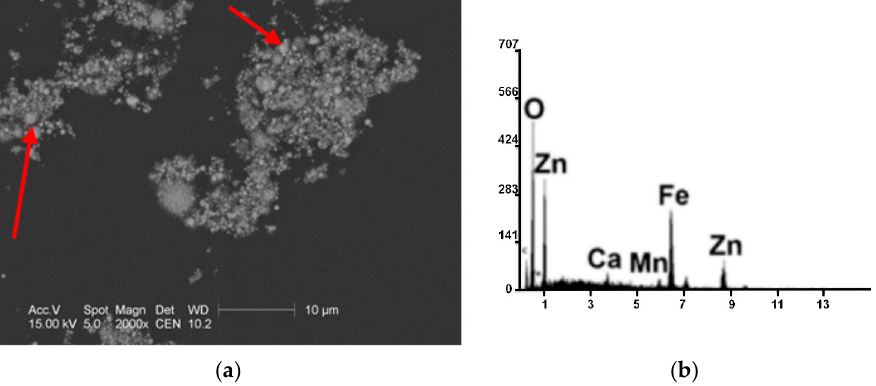
Figure 5. Particles composed of franklinite–jacobsite in steel dust, sample No. 17: ( a ) SEM image of franklinite–jacobsite particles (indicated with red arrows); ( b ) the EDS spectrum.